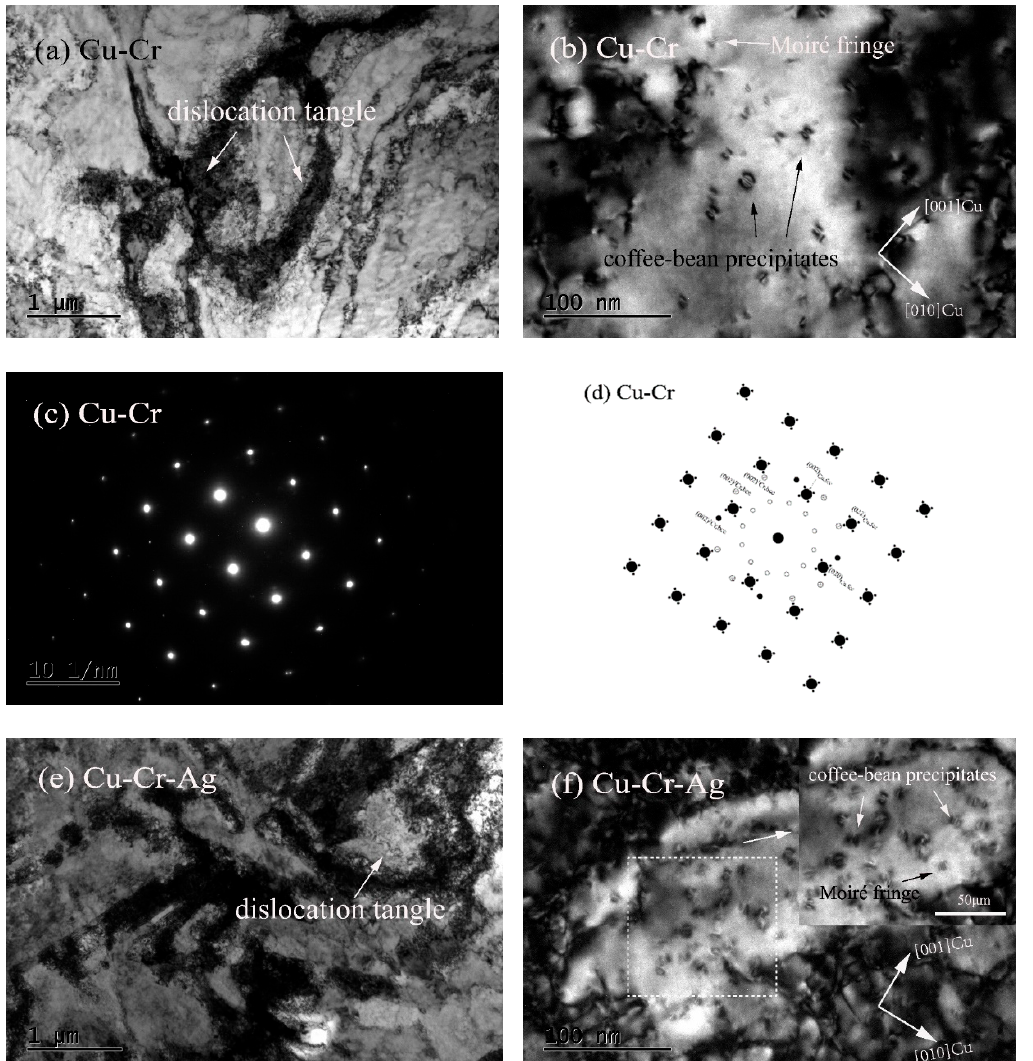
Figure 4. Morphologies and selected-area electron-diffraction (SAED) pattern of peak-aged alloys. ( a , b ) Bright-field image of Cu–Cr alloy with zone axis of (001) Cu ; ( c ) SAED pattern of ( b ); ( d ) schematic diagram of ( c ); ( e , f ) bright-field image of Cu–Cr alloy with zone axis of (001) Cu .